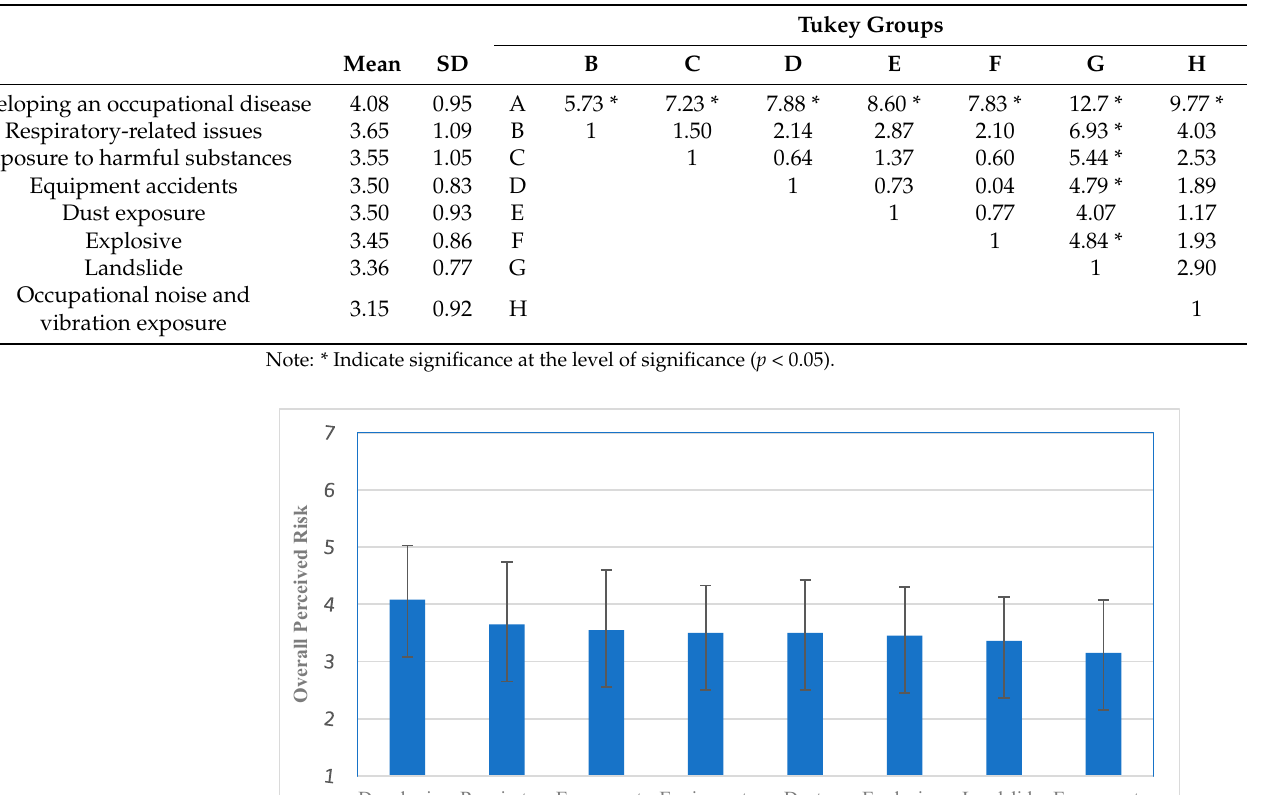
Table 5. Post-hoc comparison using Tukey’s honestly significant difference test.